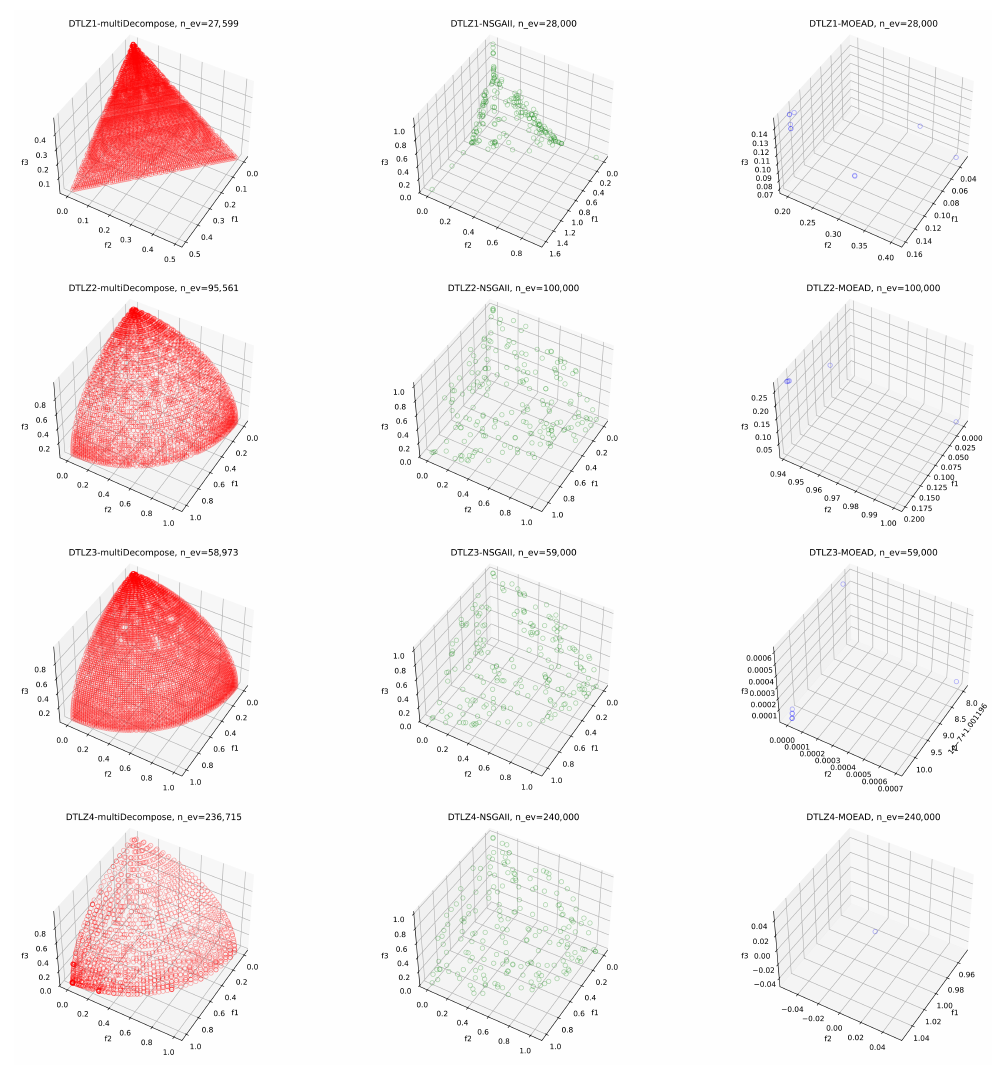
Figure 5. PFs of multiDecompose, NSGA-II and MOEA/D on all DTLZ instances where n _ ev denotes the number of the function evaluations. Table 2. Average HV value of the solutions obtained by multiDecompose, NSGA-II and